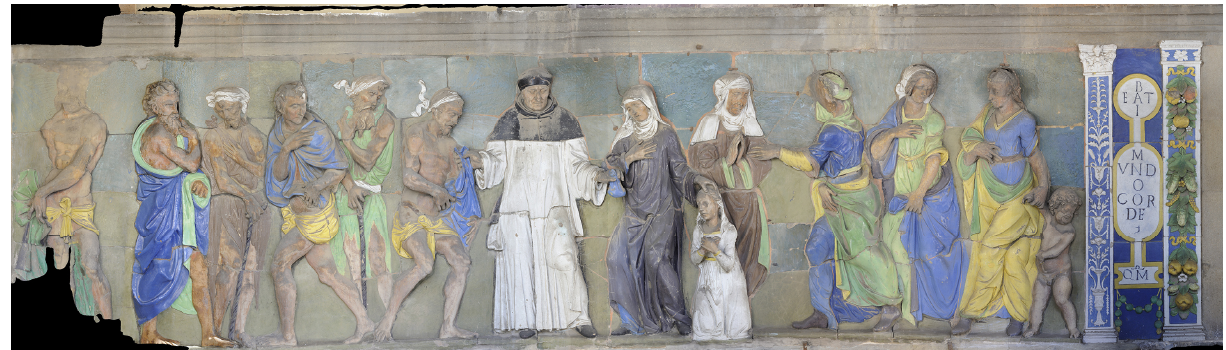
Figure 14. Ortho-image of the “Clothing the naked and taking care of widows and orphans” test